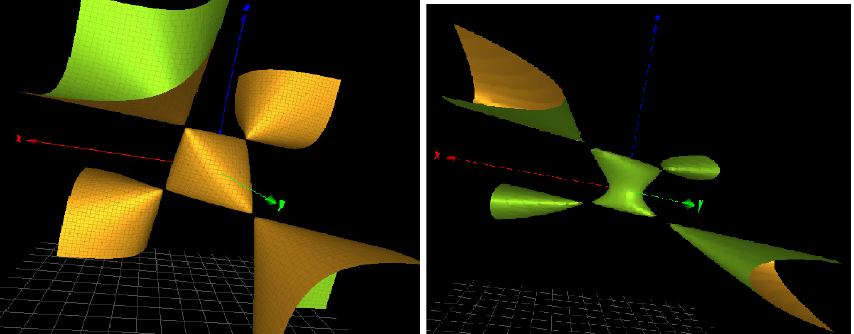
Figure 3. ( Left ): a three-dimensional picture of the SL 2 ( C ) character variety Σ H for the Hopf link complement H . ( Right ): a modified character variety of defining equation f ˜ similar